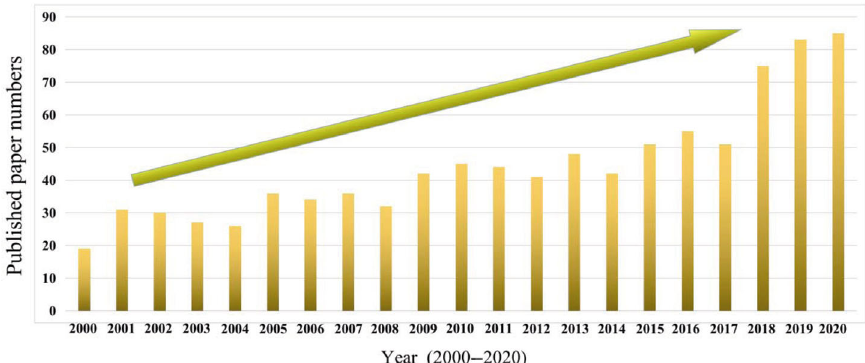
Fig. 3 Published papers on the additive manufacturing of SiC ceramic (based on Web of Science database from 2000.01 to 2020.12).